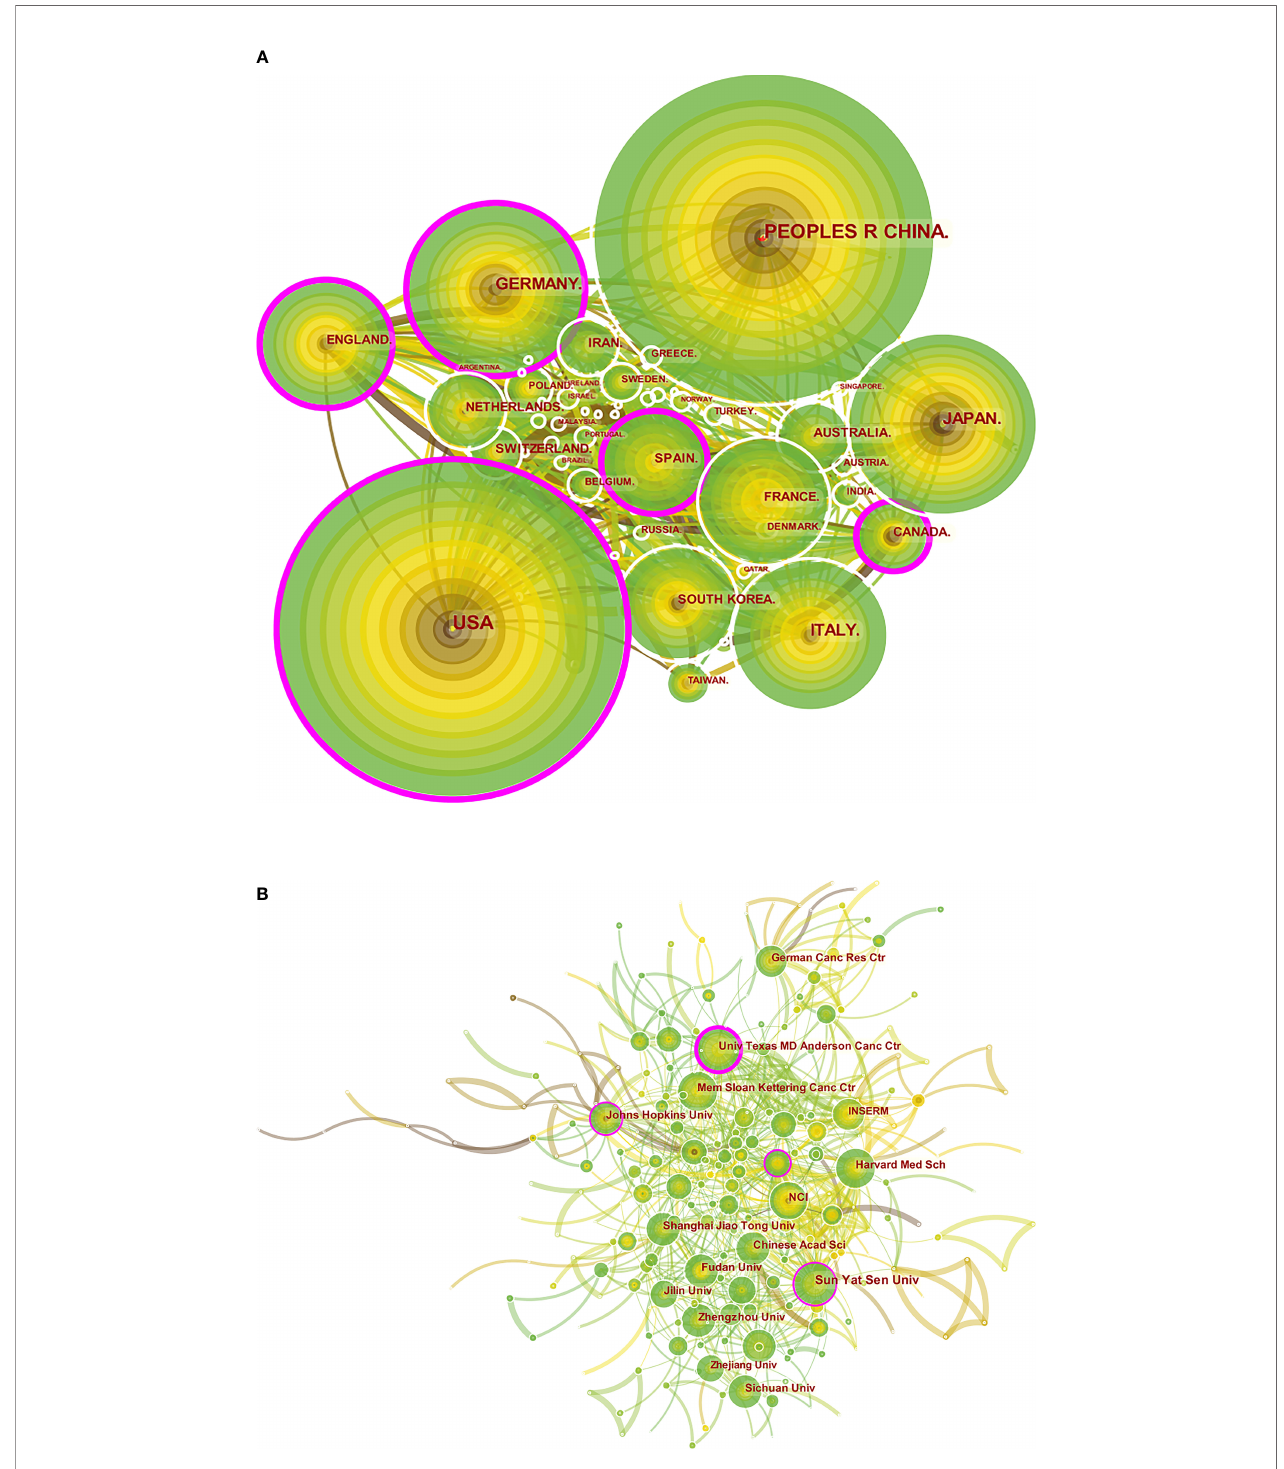
FIGURE 3 | A visual map for CiteSpace network of countries/regions and institutions associated with colorectal cancer immunotherapy. (A) Country/regional collaboration analysis; (B) Institutional collaboration analysis. The nodes represent countries/regions or institutions, and the lines connect them. Nodes represent countries/regions or institutions. The number of publications grows proportionally to the size of the nodes. The lines between the nodes represent the cooperation relationship, and the thickness of the connecting lines represents the strength of their cooperation, the closer the cooperation, the thicker the connecting lines. the nodes with the outermost purple circles have higher centrality. From 2012 to 2021, the color changes from brown to